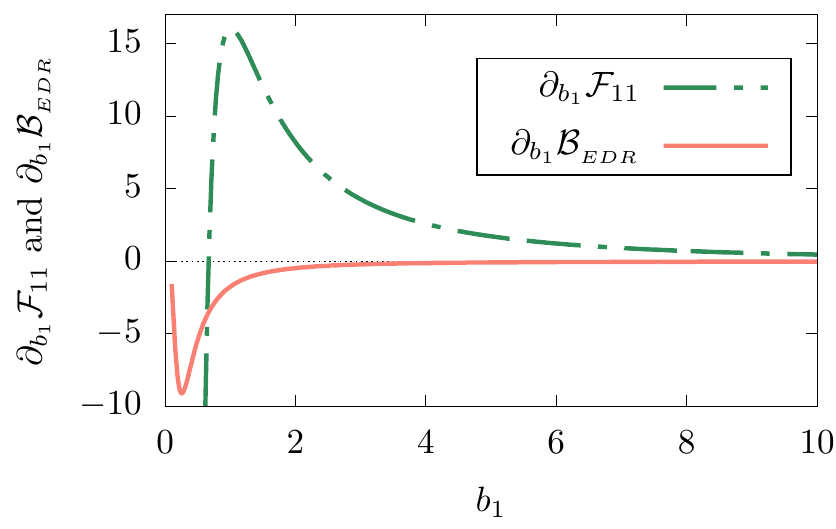
Figure 9 . Differentiation of the transition coefficient F 11 (∆ E ) with respect to b 1 plotted against varying b 1 for accelerated atoms in thermal background, denoted by the dash-dotted green line. The negative value of this quantity ∂ b F 11 (∆ E ) gives the condition for weak anti-Unruh effect. Here 1 the quantity ∂ b β F is also plotted with respect to varying b 1 and it is denoted by the solid violet 1 11 line. The positive value of this quantity gives the strong condition for the anti-Unruh-like